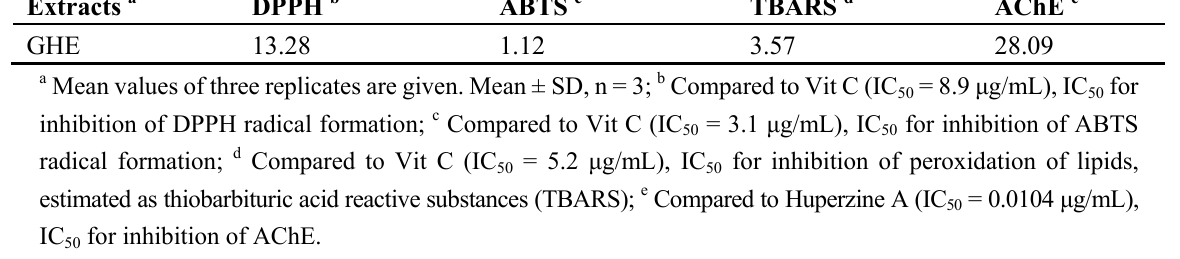
Table 1. GHE ( μ g/mL) needed to inhibit acetylcholinesterase and antioxidant activities by 50%. Extracts a DPPH